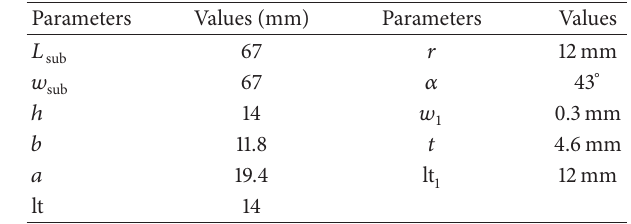
Table 2: Physical parameters of the filter. Table 3: Physical parameters of the complete